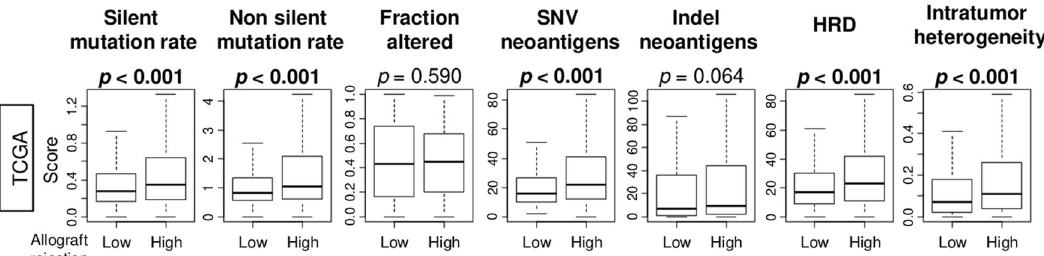
Fig. 3 Breast cancer with a high allograft rejection score was signi fi cantly associated with high levels of the mutation-related score and intratumor heterogeneity in the TCGA cohort. Boxplots of the mutation-related scores; silent and non-silent mutation rate, fraction altered, single nucleotide variation (SNV) and indel neoantigens, homologous recombination defects (HRD), and intratumor heterogeneity by low and high allograft rejection score groups. The median value was used as a cut-off to divide two score groups. p -values were calculated by the